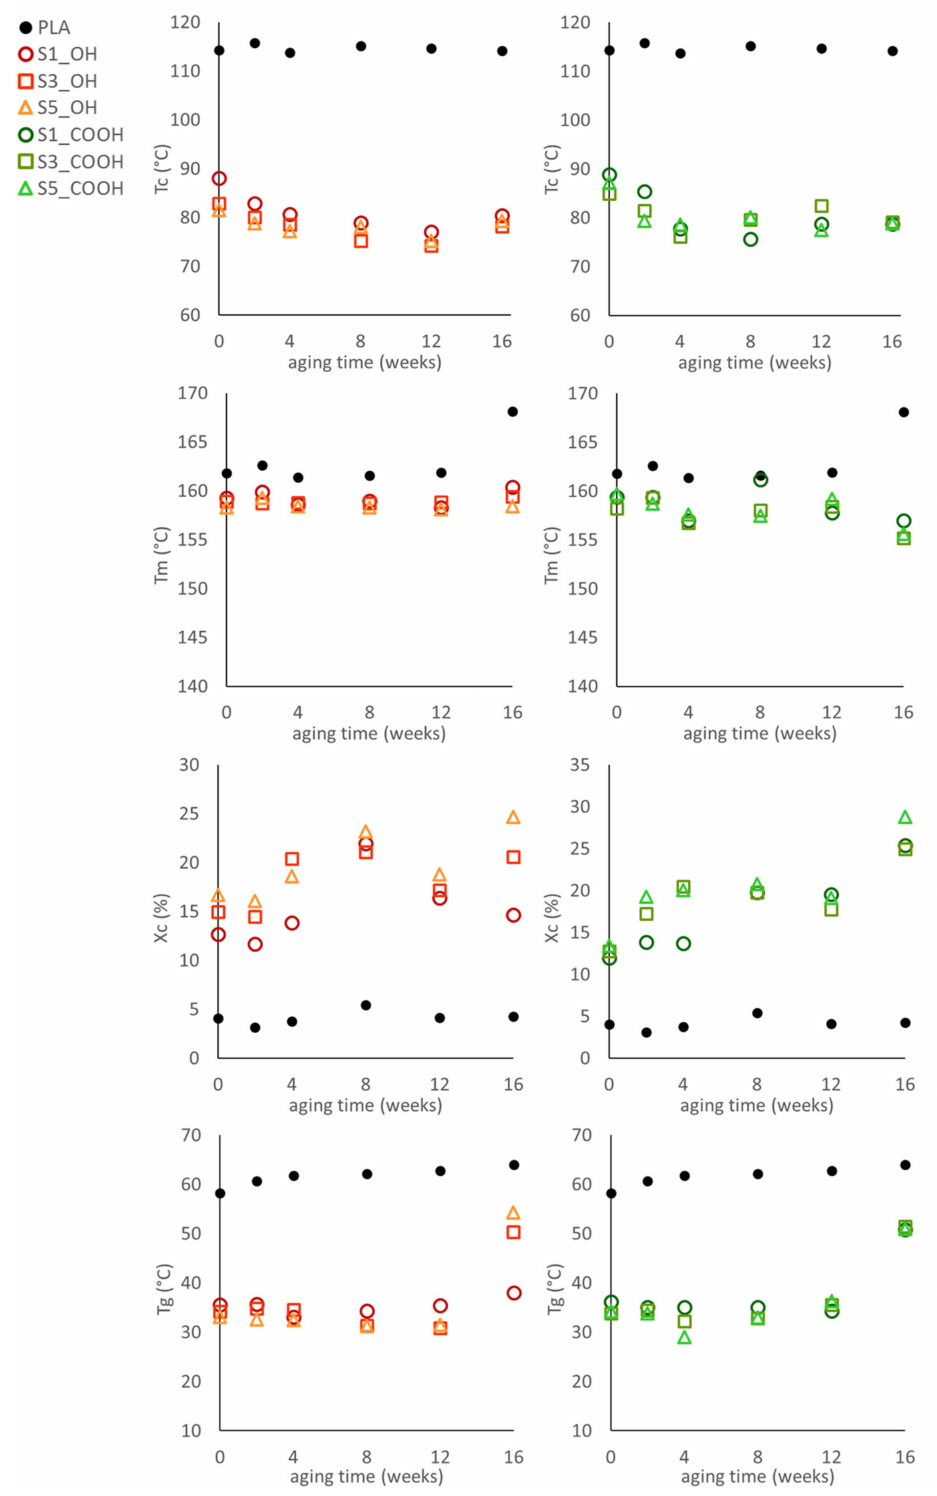
Figure 4. Calorimetric parameters: cold crystallization temperature (T cc ), melting temperature (T m ), crystallinity (X c ), and glass transition temperature (T g ) of the plasticized nanocomposites as a function of aging time. Estimated errors are ± 1 ◦ C for temperatures and ± 2% for crystallinity